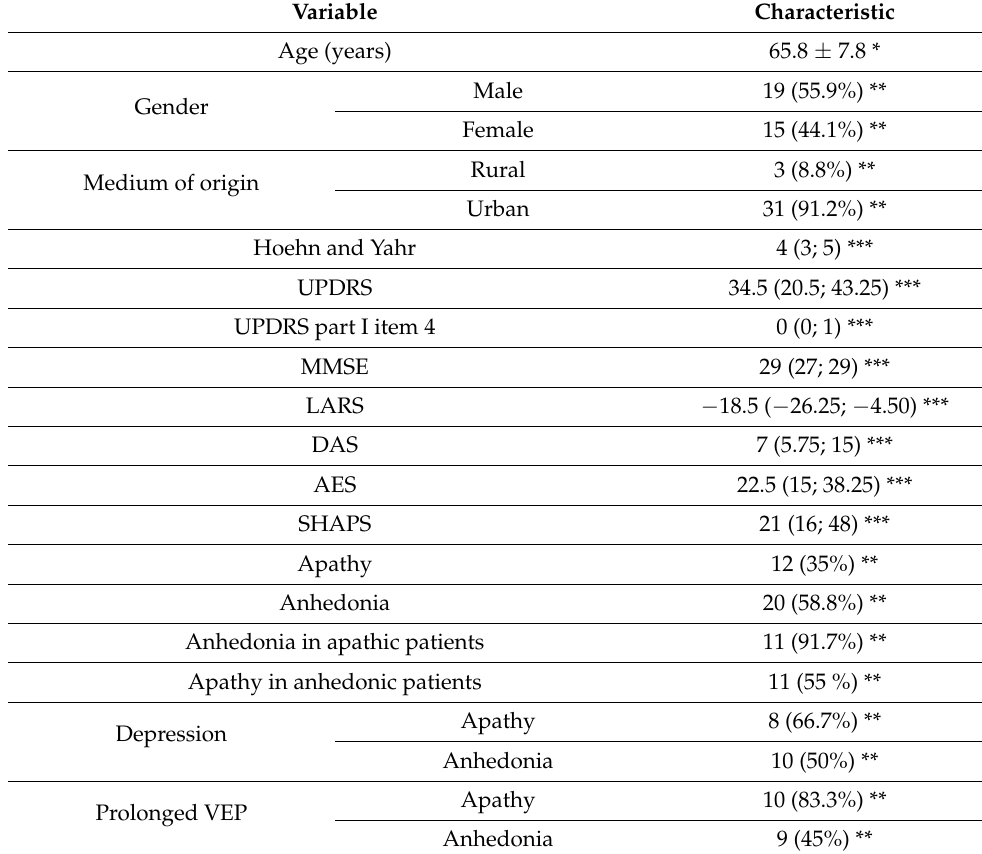
Table 1. Demographic and neurologic